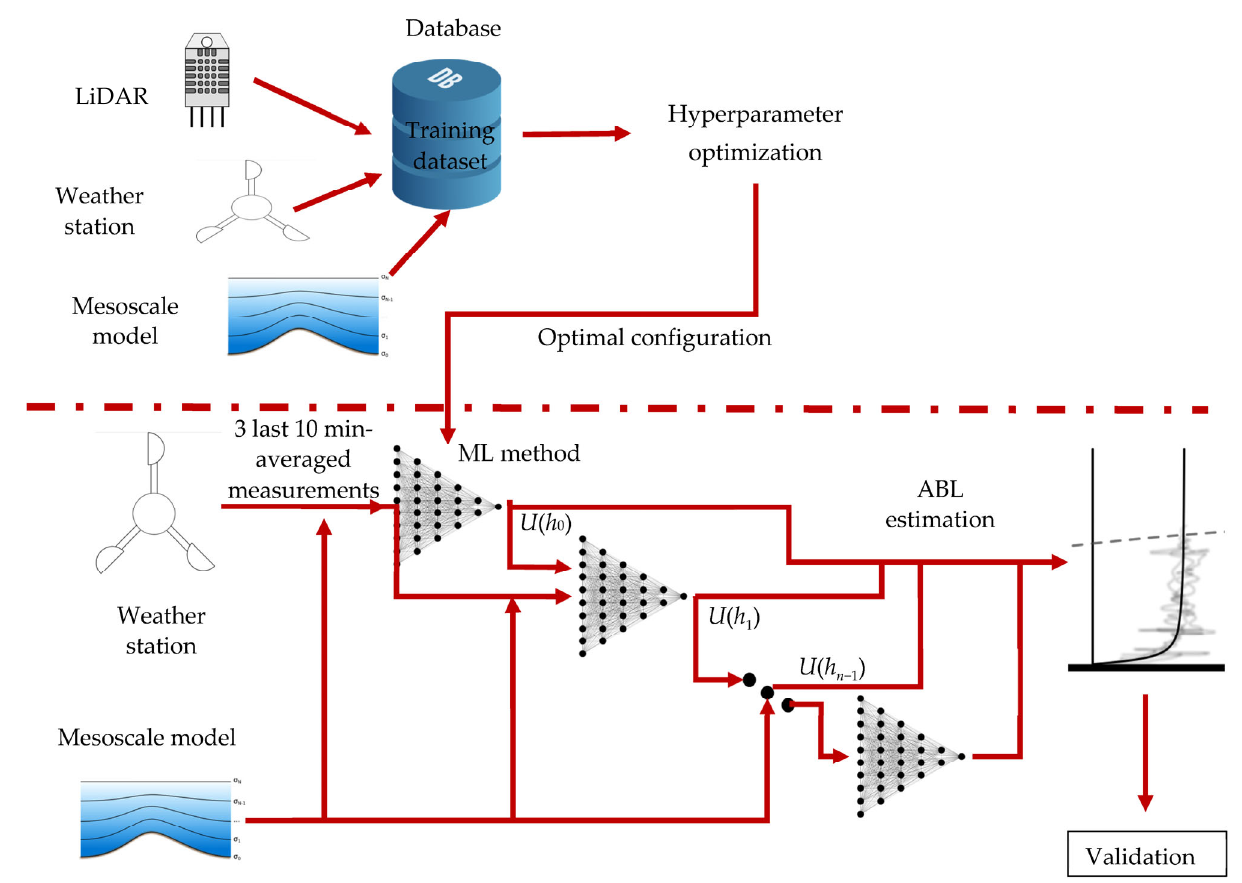
Figure 2. Dataflow for the proposed methodology.